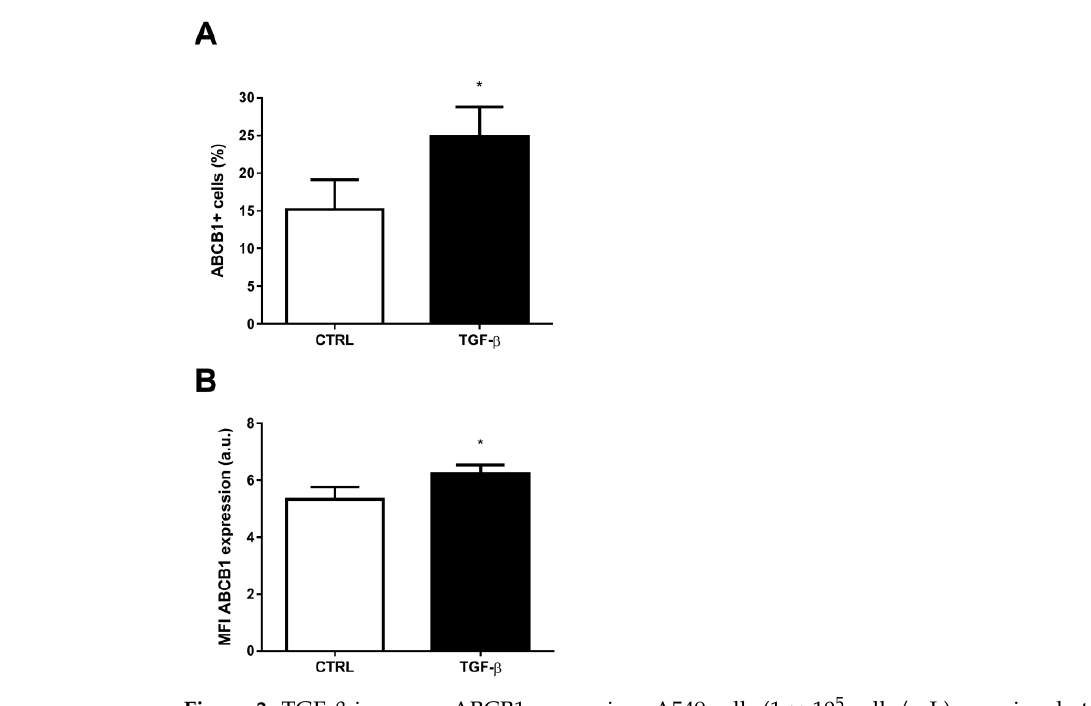
( A ) percentage of positive cells and ( B – D ) protein expression were evaluated by flow cytometry. Expression is represented by median fluorescence intensities (MFI). Bars represent mean + SEM, and the values of significance were represented by (*) for p < 0.05 from at least four independent experiments.